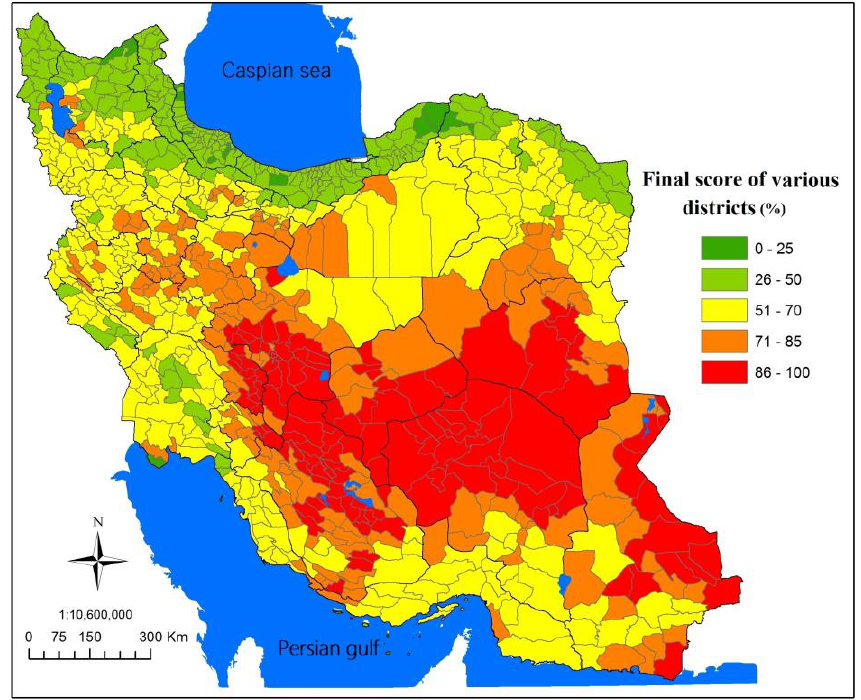
Figure 7. The priority of various districts for exploiting solar PV farms.